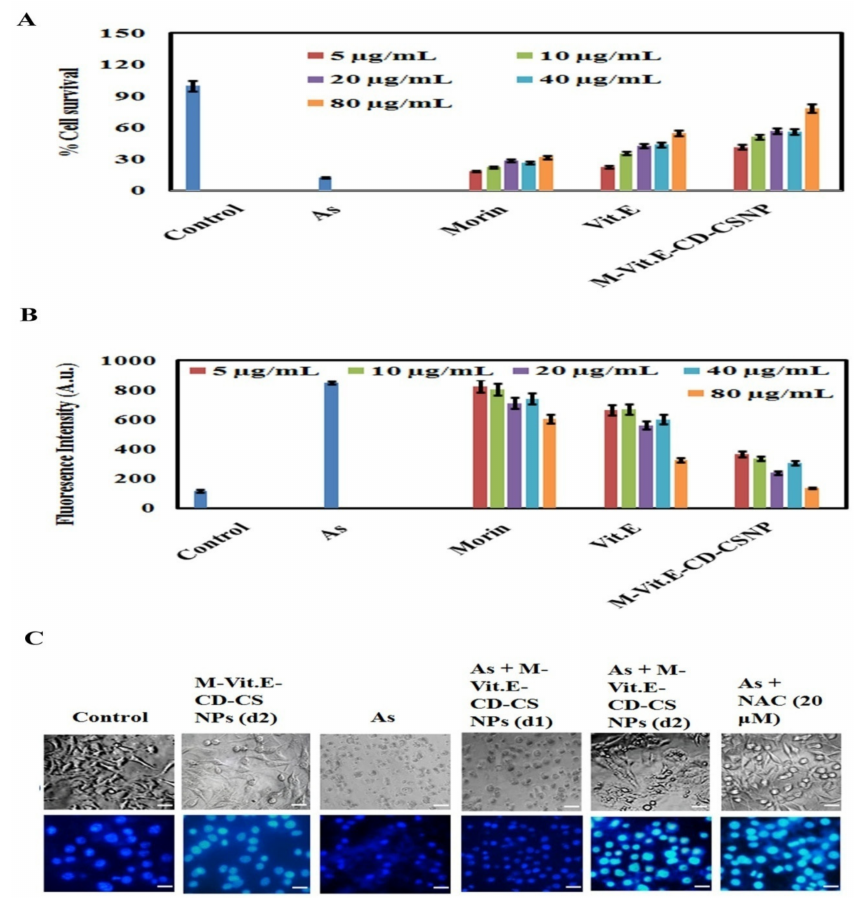
Figure 3. Effect of MOR, vitamin E, and M-Vit.E-CD-CS NPs on arsenic treated HepG2 cells. ( A ) % cell survivability was measured by MTT assay. ( B ) ROS level was detected fluorometrically. ( C ) Cell morphology was analyzed, using nuclear staining DAPI and bright field (Scale bar 10 µ